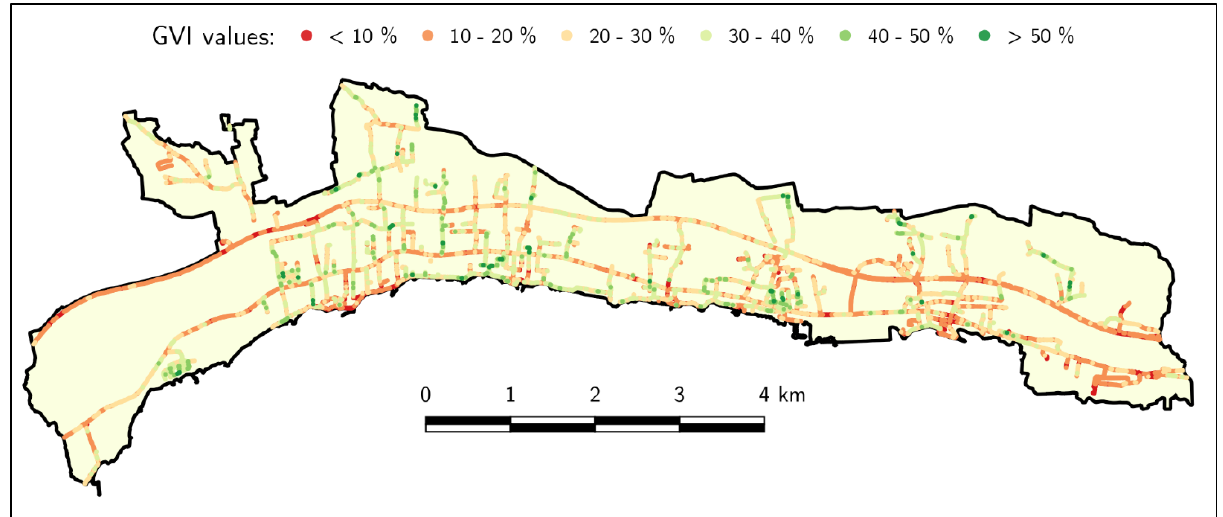
Figure 5. GSV acquisition sites colored by corresponding GVI